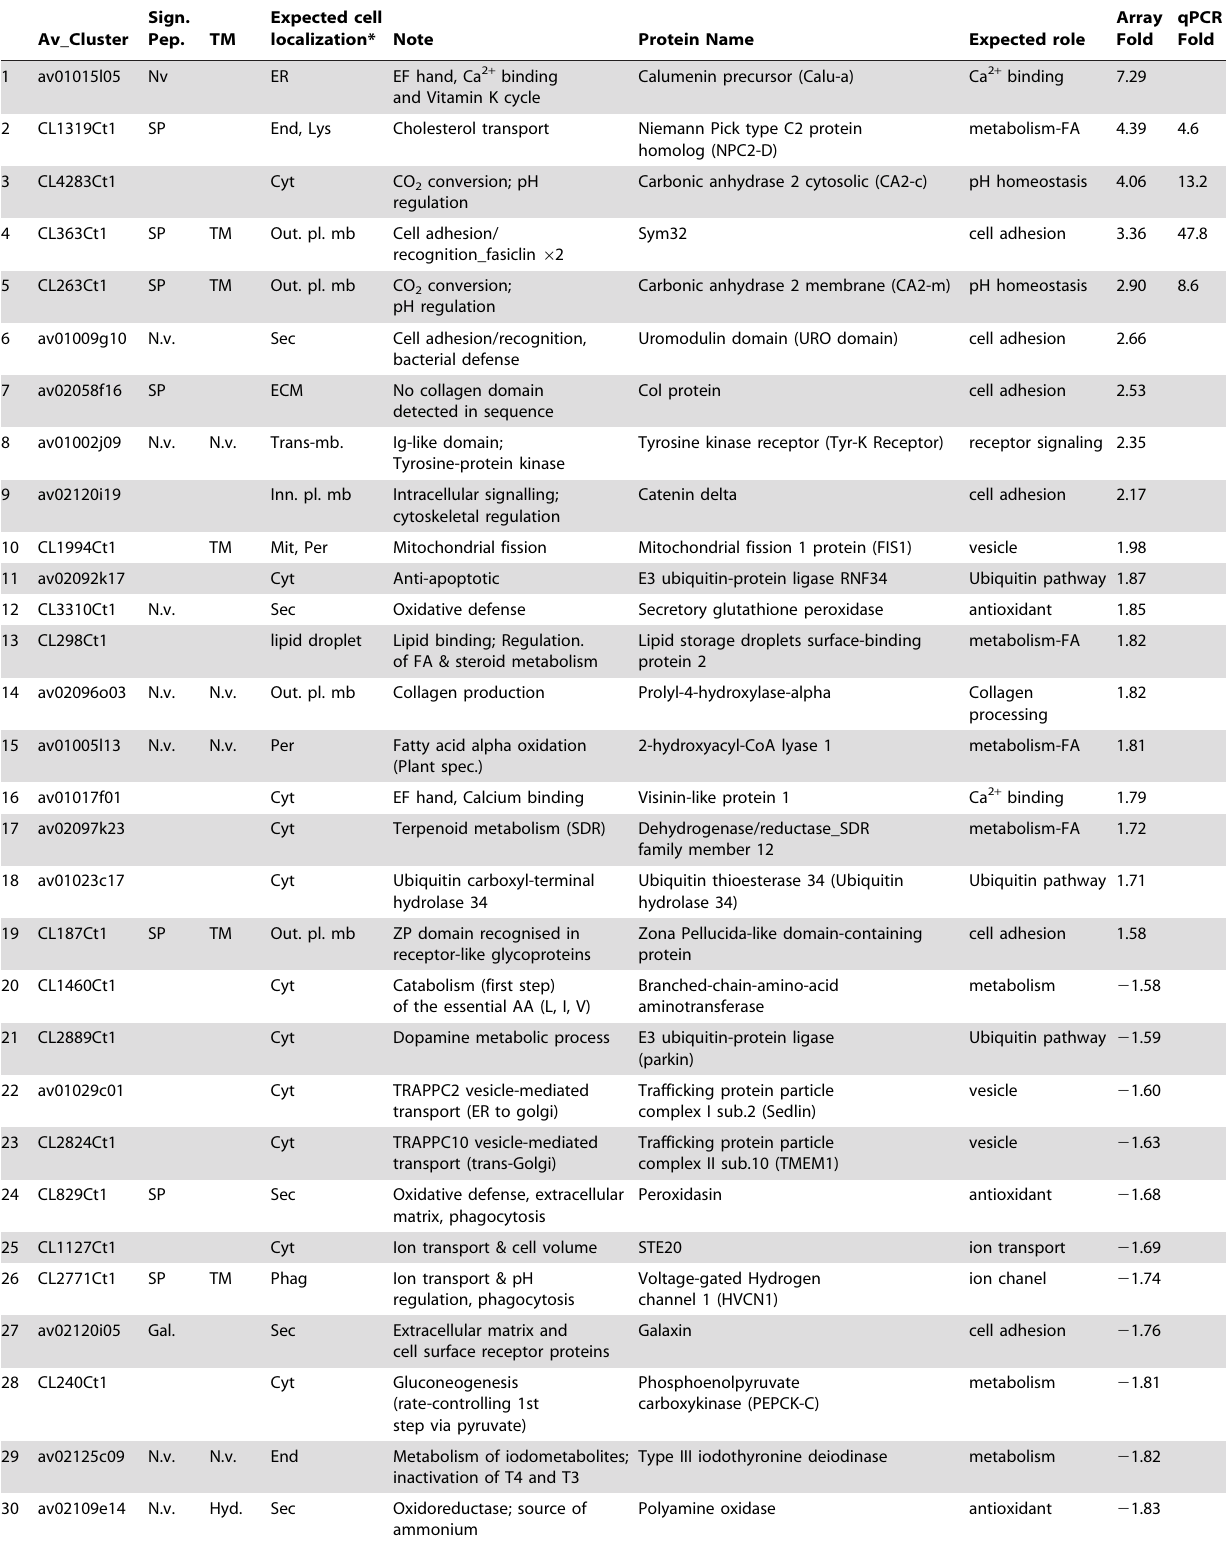
Table 1. Kern set of symbiotic genes.